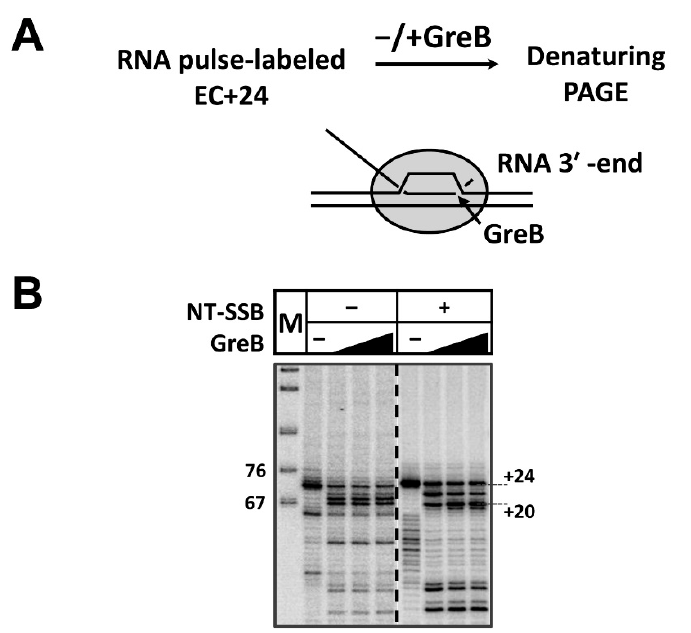
Figure 2. RNA polymerase arrested or stalled at the position +24 in a nucleosome backtracks to form EC+20. ( A ) Experimental approach for mapping positions of the active center of RNAP stalled (with- out the nick) or arrested (with the nick) during transcription of 603 nucleosome containing NT-SSB after 12 th nucleotide. RNA was pulse-labeled and arrested complexes were formed as described in Figure 1. The enzyme can backtrack, disengaging the 3 ′ end of RNA from the active center. The extent of backtracking was measured using the cleavage factor GreB to stimulate RNA cleavage by RNAP at the active center. ( B ) Analysis of pulse-labeled RNA by denaturing PAGE.